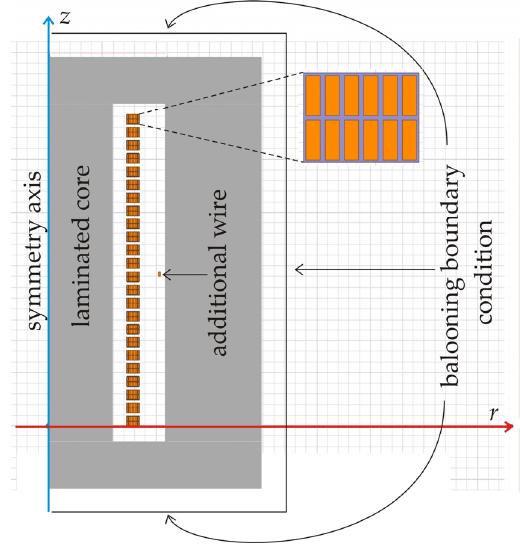
Figure 6. The 2D model used in finite element calculations.